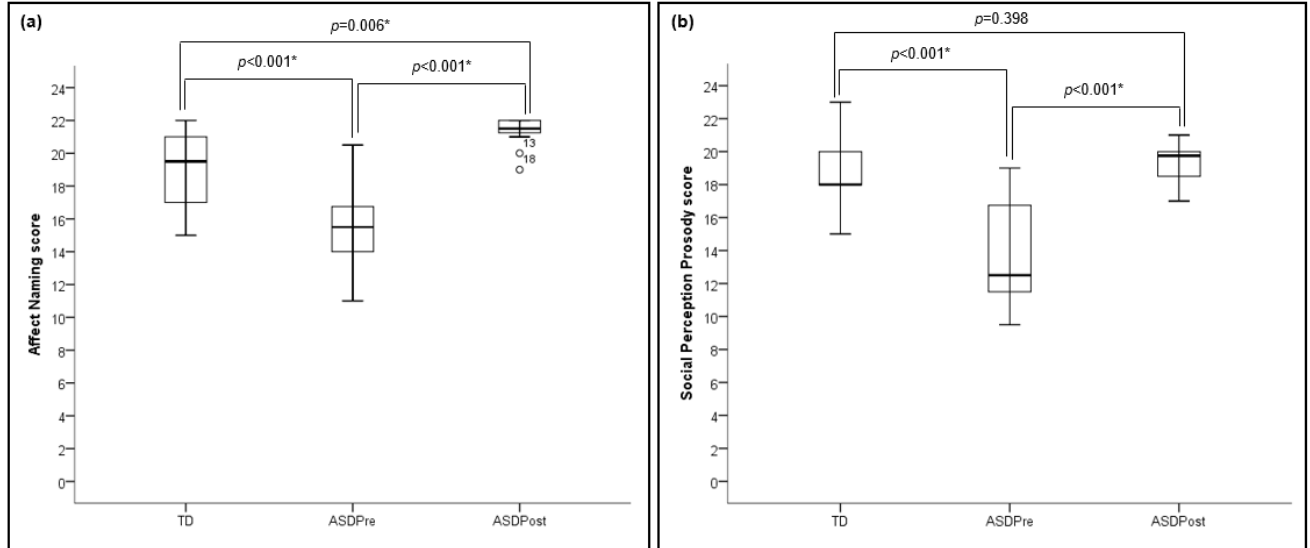
Figure 2. Behavioral social perception results from the Wechsler ACS Social Perception Subtests highlighting differences in performance between TD and ASD groups; and differences in performance pre- and post-intervention for the ASD group. ( a ) results for Affect Naming scores; and ( b ) results for Social Perception Prosody scores. * represent statistically significant differences.